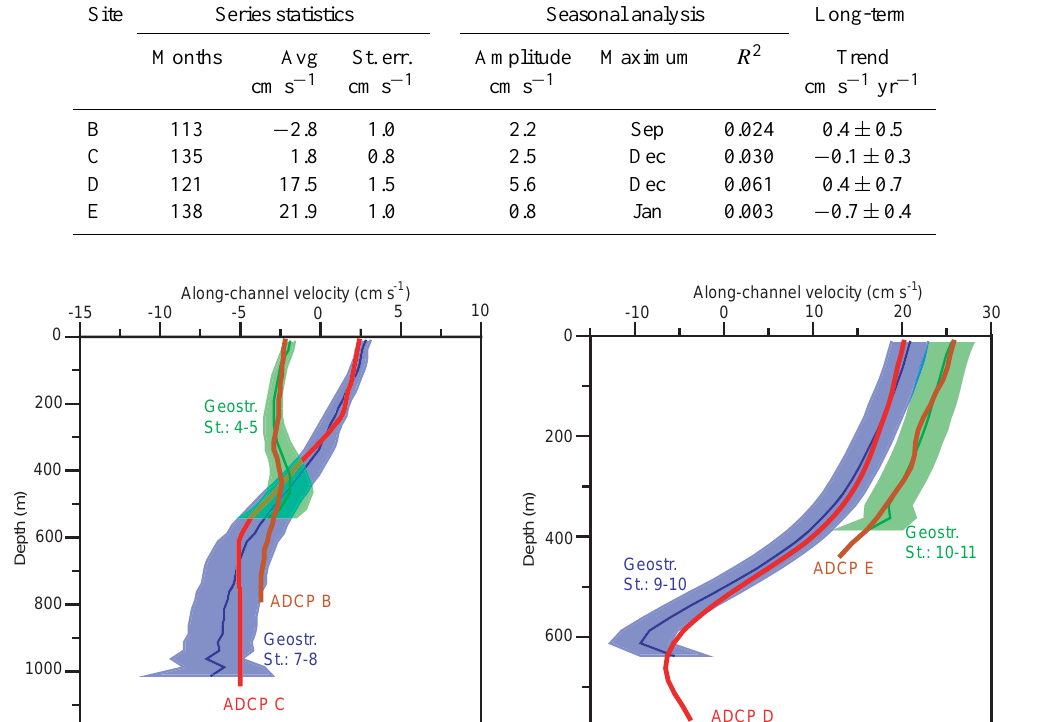
Fig. 5. Comparison of vertical velocity profiles from ADCP and geostrophy (based on CTD profiles between 1995–2009). The geostrophic profiles are illustrated by the average profile (blue or green line) surrounded by an area (blue or green) representing the average ± the standard error. The geostrophic profiles have been offset so that the average velocity between 0 and 325m for each station pair fits the AW velocity of the